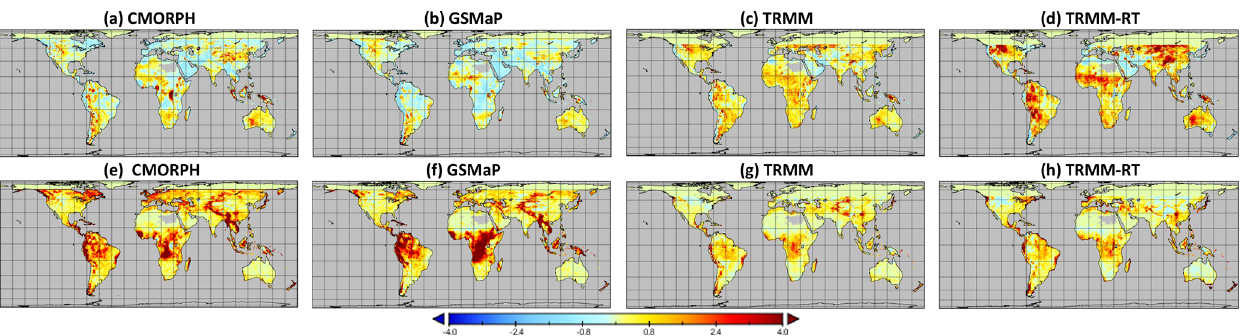
Figure 4. Increase in extreme precipitation event occurrence in relation to MSWEP. Subtracting extreme high event occurrence rates in the MSWEP precipitation input from the rates in the CMORPH precipitation input gives map (a) , and (b) to (d) are the same calculation using GSMaP, TRMM and TRMM-RT instead of CMORPH. (e) to (h) are the same calculation, but for extreme low event occurrence (i.e. the averages of the upper and lower rows are effectively the maps Fig. 3a and b, respectively). The clear lines at 50 ◦ N (TRMM, TRMM-RT) and 60 ◦ N (CMORPH, GSMaP) show the bounds of data validity for these products (Table 2). Note that only isolated global areas exceeded 4 events per year, so the scale is restricted to − 4 to + 4 events per year.